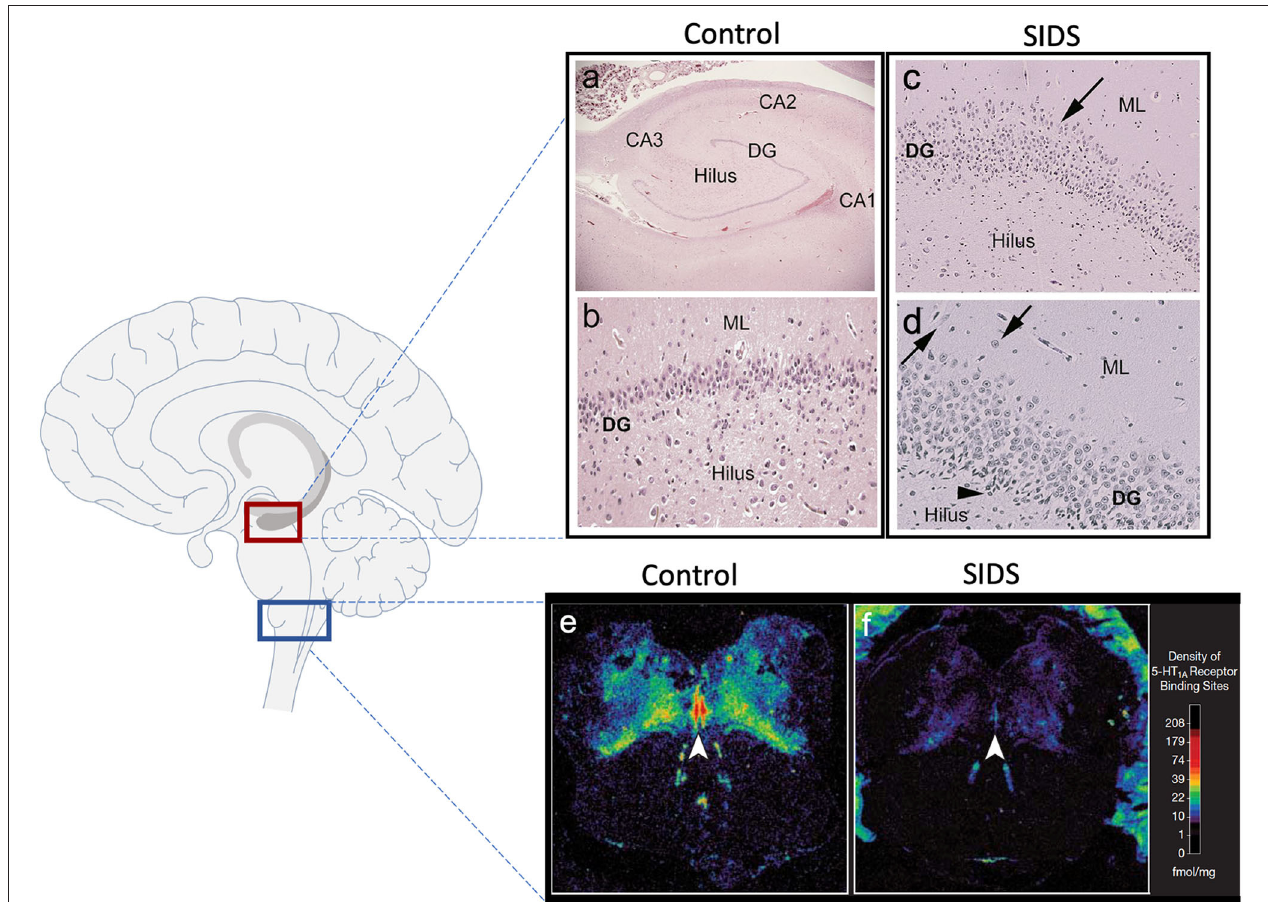
FIGURE 1 | Hippocampal and medullary pathology identified in SIDS infants. The diagram on the left shows general brain structure with the hippocampus and medulla highlighted with red and blue boxes, respectively. Images (a–d) show hematoxylin and eosin staining of the hippocampus. Hippocampal anatomy is shown at 4x in a control infant for reference (a) . The dentate gyrus (DG) in a control infant is shown at 10x with a densely packed, single layer of granule cells (b) . The hippocampus of a SIDS infant displays (c) bilamination of the DG (arrow), (d) single, ectopic granule cells in the molecular layer (arrow), and (d) progenitor cells in the subgranular layer (arrowhead). Hippocampal images were modified from Kinney et al. ( 8). Examples of medullary 5-HT 1A autoradiography are shown in (e,f) . The density of 5-HT 1A receptor binding, including in the raphe obscurus (arrowhead), is visually lower in a SIDS case (f) compared with a control (e) . The receptor binding surrounding the control medulla (e) represents binding in cerebellum tissue. A colored density scale is included for reference. Brainstem images were modified with permission from Paterson et al. (4). DG, dentate gyrus; CA, cornu ammonis; ML, molecular